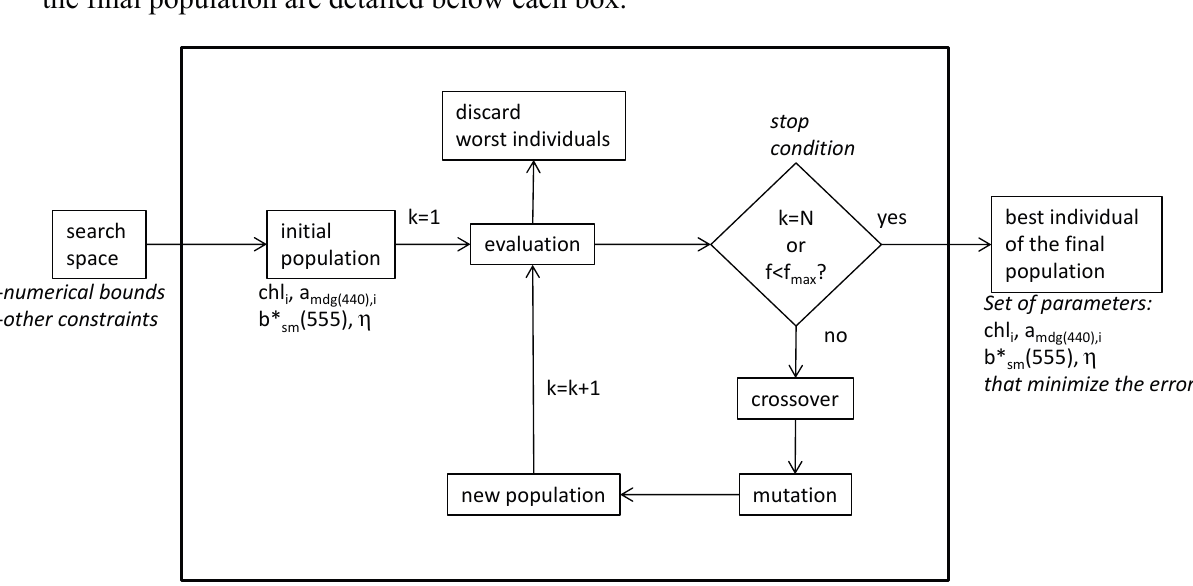
Figure 4. Scheme of the internal functioning of the genetic algorithms (GA) optimization procedure. The contents of the search space, initial population and the best individual of the final population are detailed below each box.